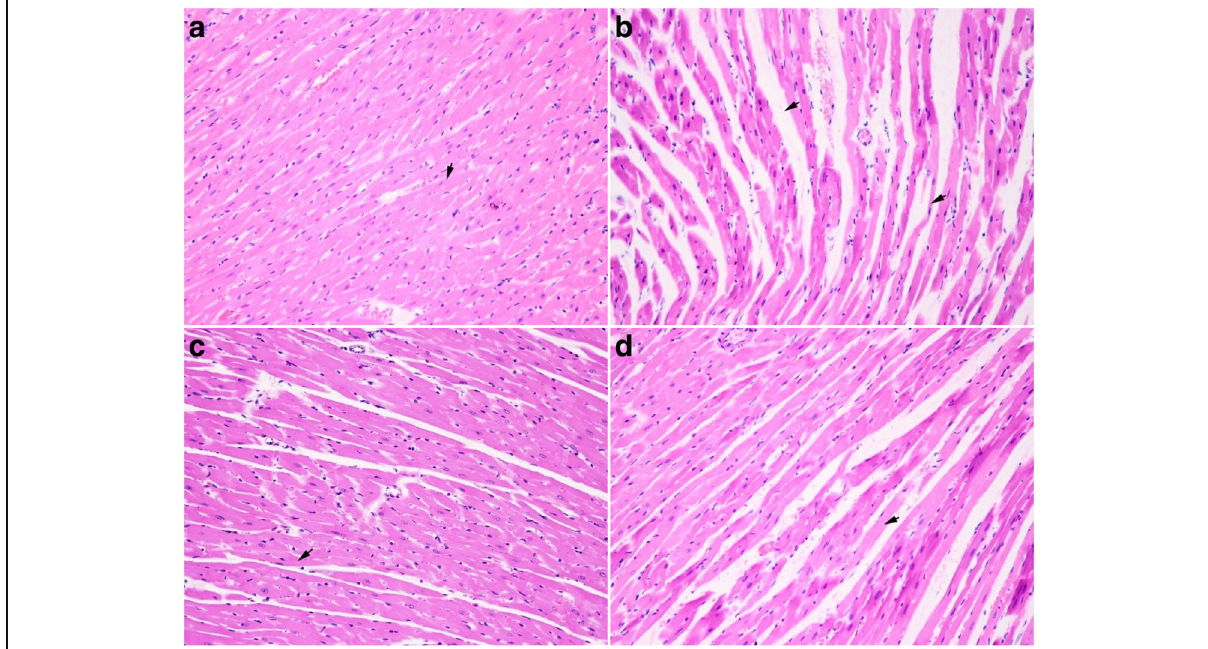
Fig. 4 The effect of EXD on the left ventricle structure in OVX rats (HE staining, 20×). a Nornal myocardial fiber (indicated by arrowhead) in left ventricle of SHAM group rat; b Widening myocardial gap (indicated by arrowhead) and cytoplasmic condensation (indicated by arrowhead) shown in left ventricle of OVX group rat; c Myocardial fiber close to normal shown in left ventricle of E2 group rat; d Amelioration of cytoplasmic condensation in myocardial fiber shown in left ventricle of EXD group